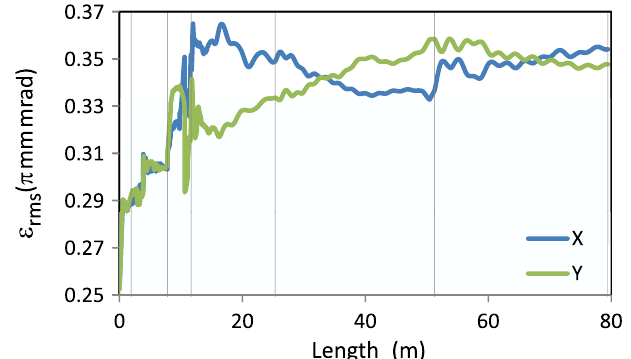
FIG. 2. (Color) Transverse emittance evolution along LINAC4, different sections which are separated with lines are LEBT, RFQ, Chopper, DTL, CCDTL, and SCL, respectively.